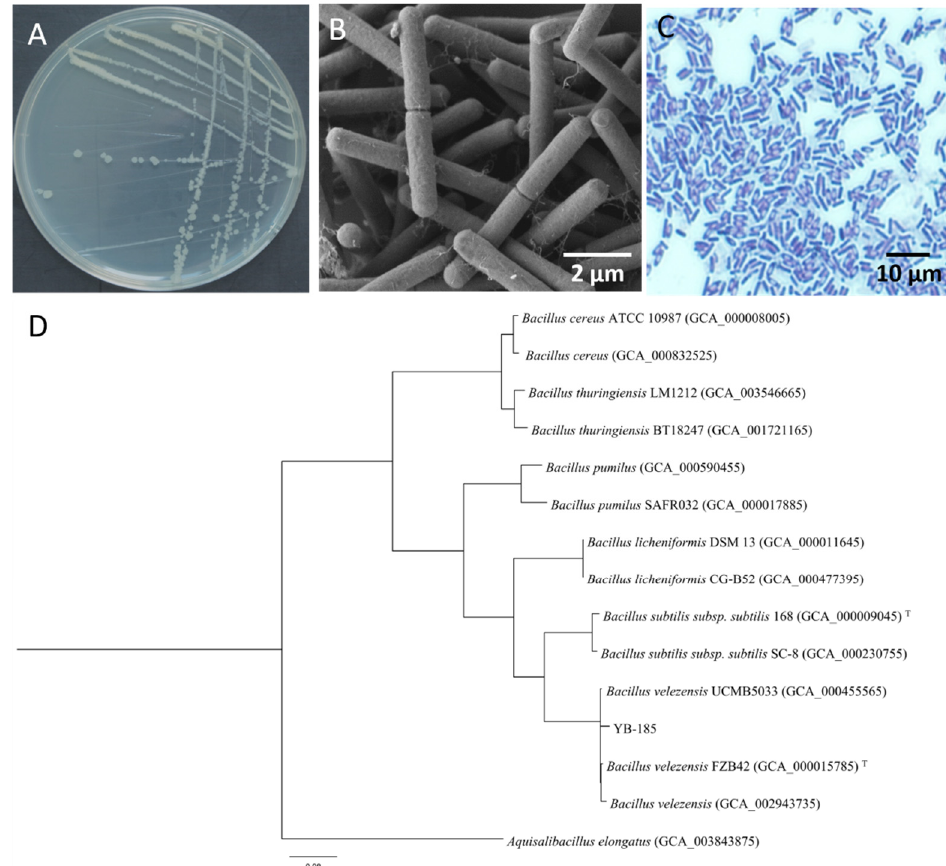
Figure 2. Characteristics of YB-185. ( A ) Colony morphology of YB-185 on NA at 24 h and 30 °C; ( B ) SEM of YB-185 cells (10,000×); ( C ) light microscopy of YB-185 cells and endospores with Gram staining (1600×); ( D ) maximum likelihood tree of combined 16S rRNA and gyrA sequences from YB-185 and other Bacillus spp. The tree was generated using IQ-Tree (XSEDE in the CIPRES Science Gateway) and rooted with the combined 16S rRNA and gyrA sequences of Aquisalibacillus elongatus. Scale bar shows a 0.08 genetic difference.